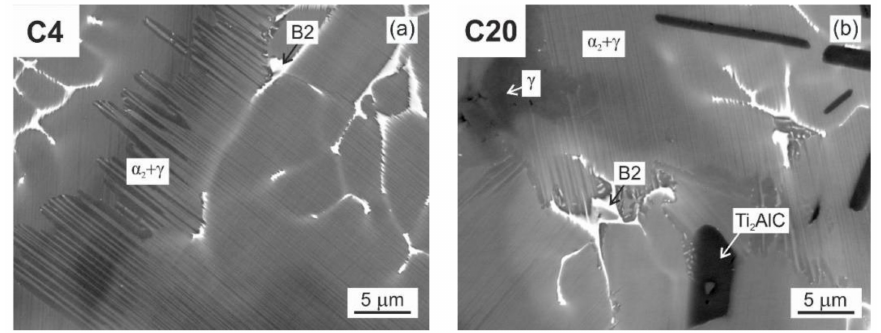
Figure 6. BSE micrographs showing the microstructure of as-cast alloys: ( a ) C4 alloy; ( b ) C20 alloy.